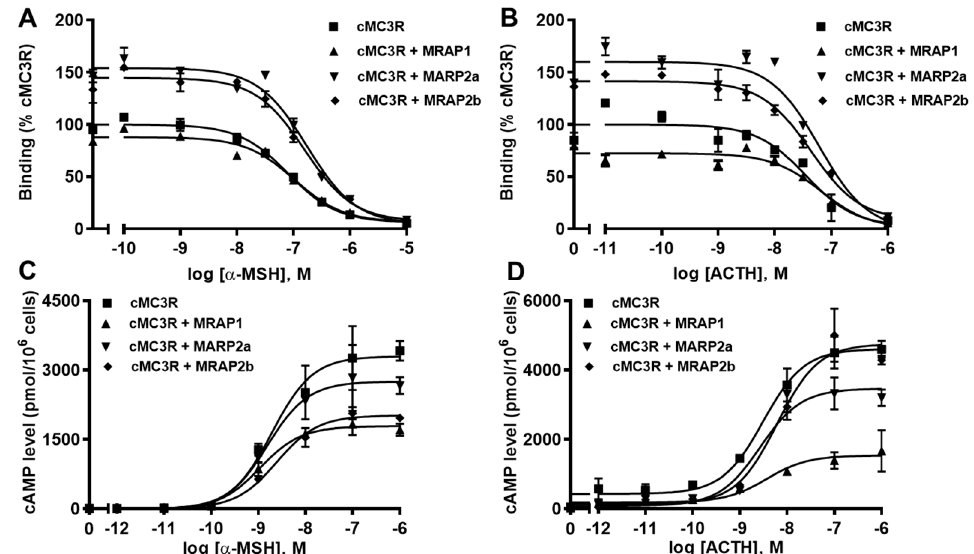
Figure 7. Modulation of cMC3R pharmacology by MRAPs. Ligand binding ( A , B ) and signaling ( C , D ) properties of cMC4R to α -MSH or ACTH (1-24) upon co-expression of cMC4R with cMRAP1, cMRAP2a or cMRAP2b were measured. Results of binding properties were calculated as % of cMC4R without MRAPs, from duplicate determinations within one experiment. All experiments were performed at least three independent times. Table 3. The effect of MRAPs on ligand binding properties of cMC3R.